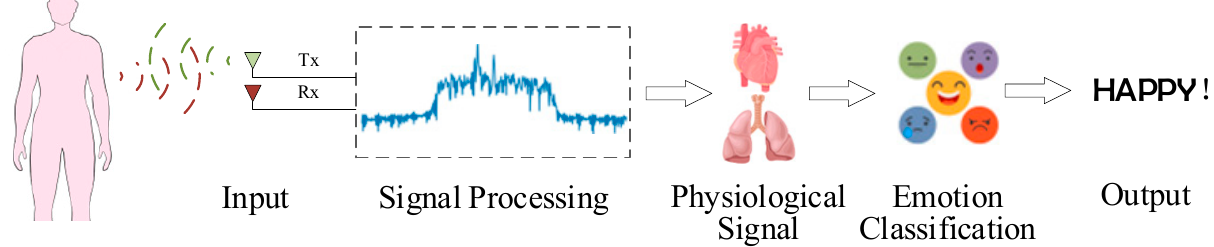
Figure 6. Process of emotion recognition based on radar sensor.